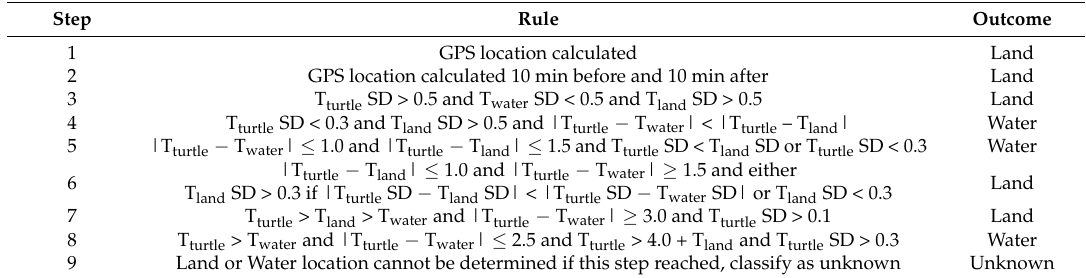
Table A1. Rules used to classify each 10-minute wood turtle ( Glyptemys insculpta ) location to be on land or in water, based on GPS location, and temperature taken on the carapace of a turtle’s shell (T turtle ), and environmental temperature loggers in shade (T shade ), in sun (T sun ), and in water (T water ). In the table T land = either T shade or T sun . Standard deviation (SD) was calculated across three temperature readings before and after each T turtle , T water , or T land value (i.e. across 60 min). Step Rule Outcome